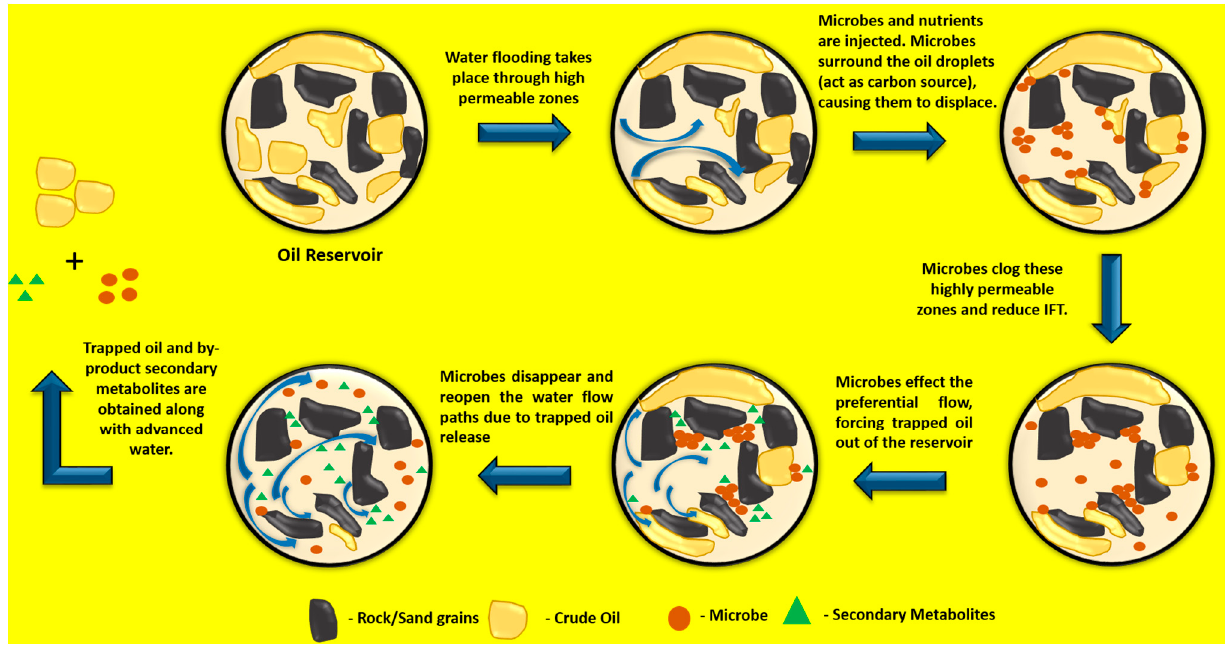
Figure 3. Diagrammatic illustration of a synopsis of the MEOR process.